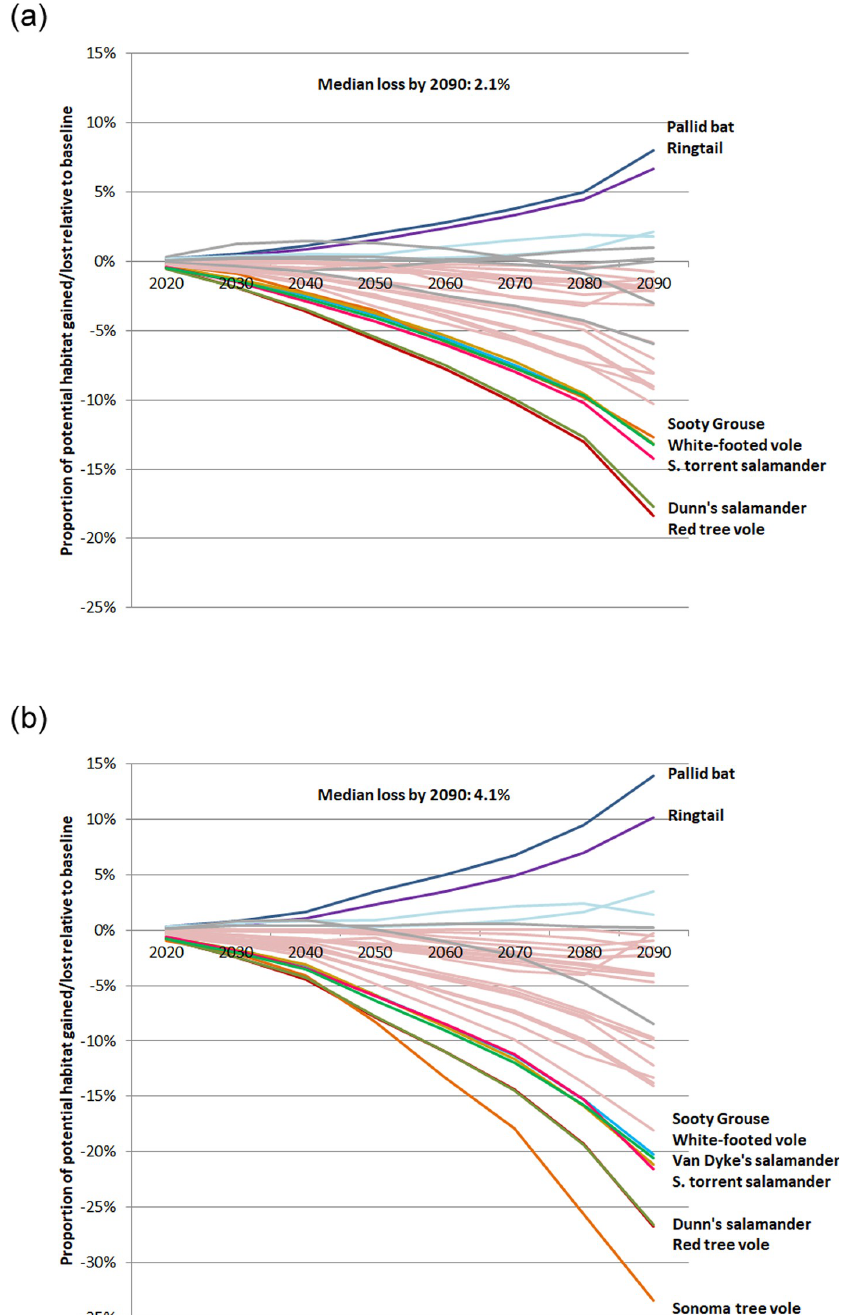
Fig 5. The proportion of FIA plots gained or lost within a species’ entire range that is potential habitat, under the (a) climate change only scenario and (b) climate change + carbon pricing scenario, relative to the baseline scenario. We list selected species’ names corresponding to solid colored lines on the right side of each plot, from largest gains (top) to largest losses (bottom). Other species with significant projected gains are represented by a light aqua line, species with significant losses by a light red line, and species with non-significant changes by a grey line (see Table for % change values, including prediction intervals, by scenario, for each species). a. Effects of climate change. b. Effects of climate change + carbon